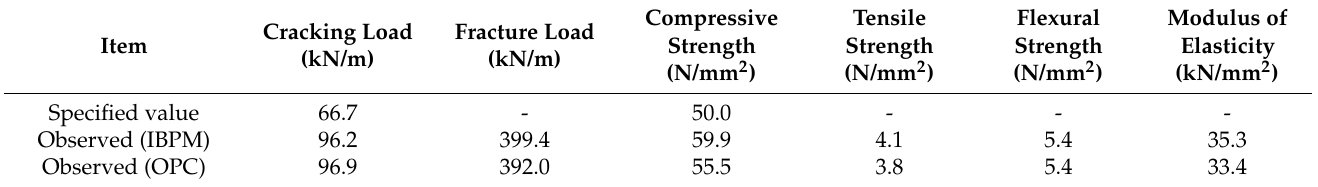
Table 10. Load-bearing capacities of box culvert specimens and mechanical properties of